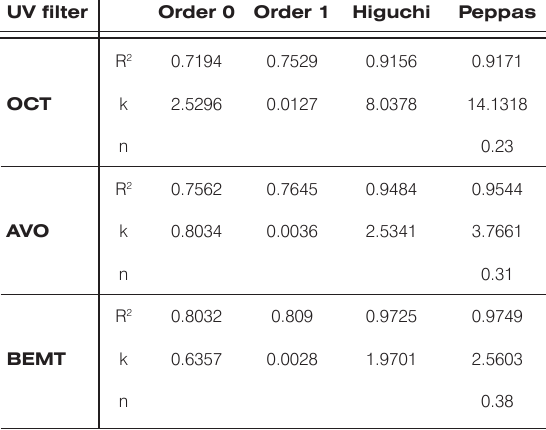
Table 4. The release kinetics parameters of AVO, OCT from NLC 5 and of BEMT from NLC